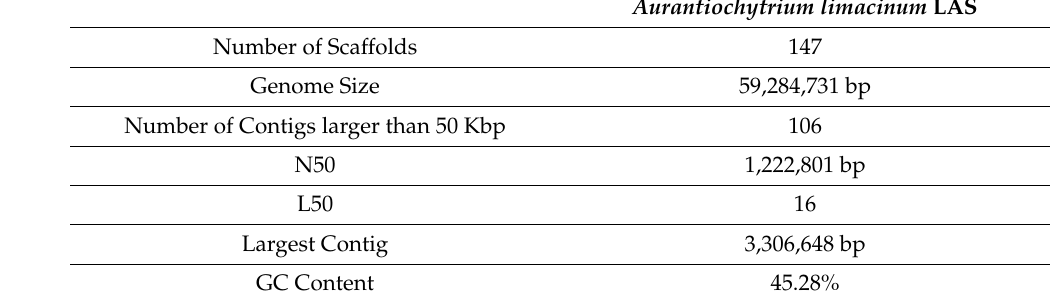
Table A2. Genome assembly statistics.